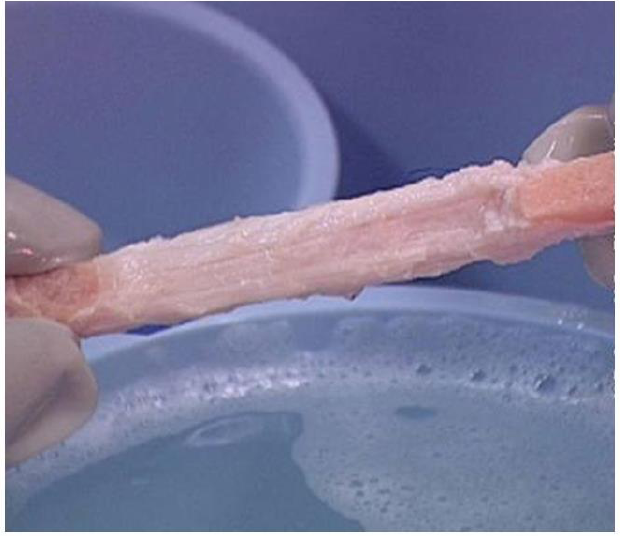
Figure 4. Bioprosthesis prepared from porcine bone-patellar-tendon-bone (length of ~10 cm and width of ~1 cm) for reconstructing torn ACL in humans. Note the two bone-plugs of the patella and tibia bones.